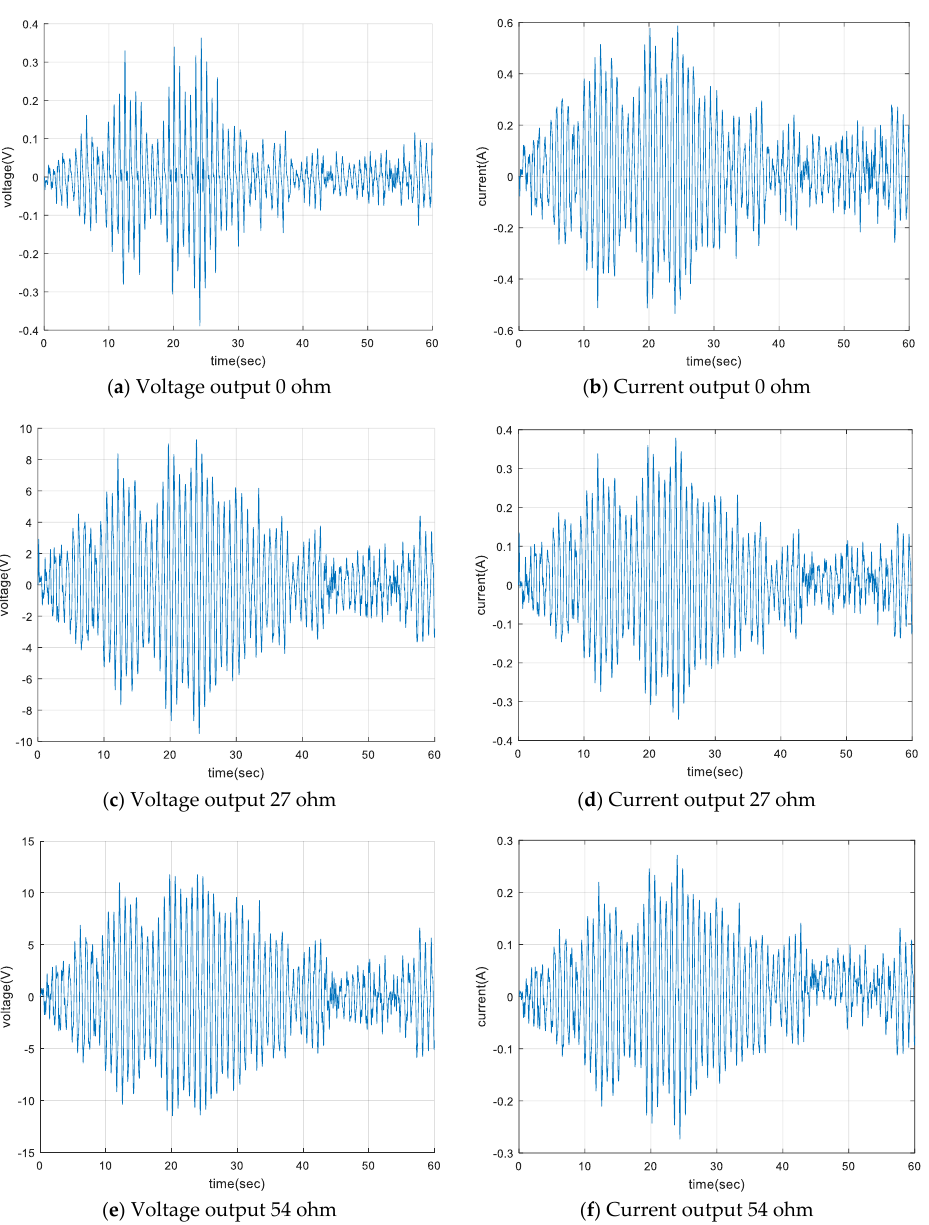
Figure 16. Voltage and current output.